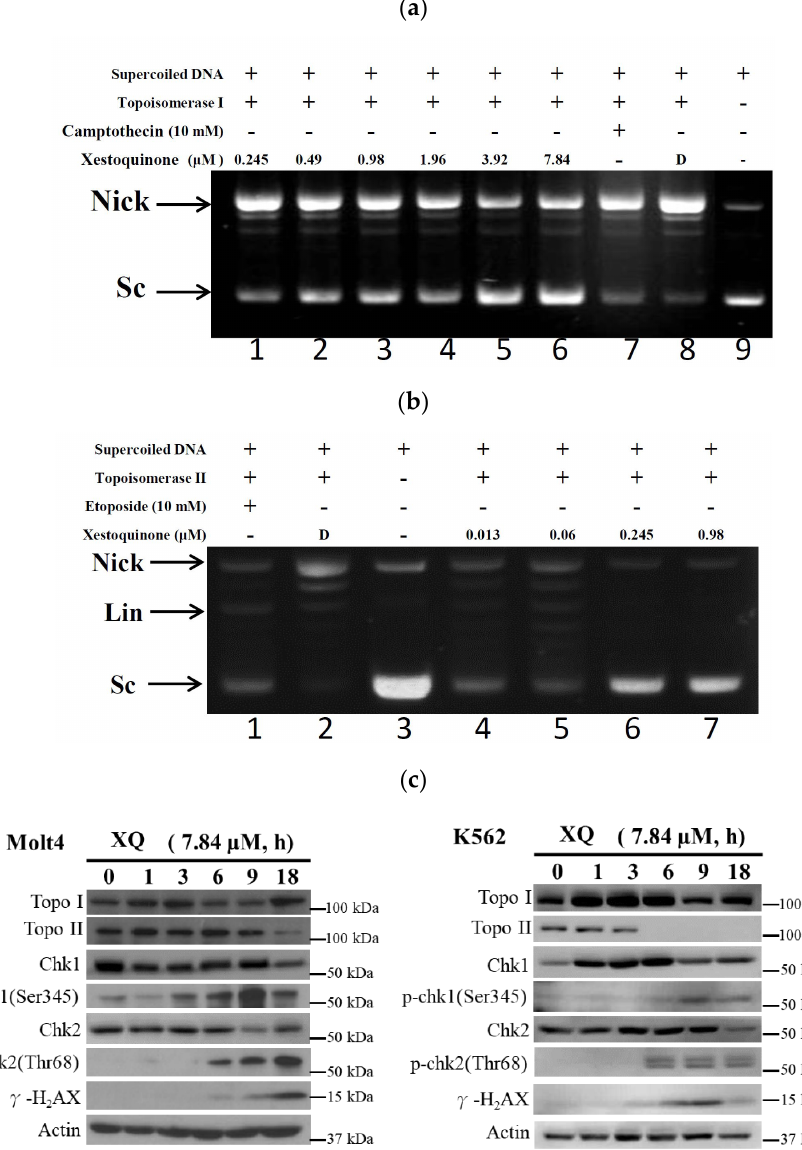
Figure 3. Effect of XQ on Topo I and II activity. ( a ) The effect of XQ on Topo I mediated supercoiled pHOT1 plasmid DNA relaxation with the cell-free system. Lanes 1-6: XQ (0.245, 0.49, 0.98, 1.96, 3.92, and 7.84 µM); Lane 7: Positive control, camptothecin (10 mM); Lane 8: Plasmid DNA + Topo I + solvent control (induction of DNA relaxation); Lane 9: Negative control plasmid DNA (supercoiled DNA). Nick, nicked DNA; Sc, supercoiled DNA. ( b ) The effect of XQ on Topo II mediated supe- coiled pHOT1 plasmid DNA relaxation with the cell-free system. Lane 1: Positive control, etoposide (10 mM), as Topo II poison (induction of linear DNA); Lane 2: Plasmid DNA + topo IIα + solvent control (induction of DNA relaxation); Lane 3: Negative control plasmid DNA (supercoiled DNA). Lanes 4-7: XQ (0.013, 0.06, 0.245, and 0.98 µM). Nick, nicked DNA; Sc, supercoiled DNA; Lin, linear DNA. ( c ) Effect of XQ on the expression of topo IIα and DNA damage -related proteins of Molt-4 cells and K562 cells. Molt-4 and K562 cells were treated with XQ (7.84 µM) for the indicated time intervals. The protein expression was analyzed with Western blotting. Actin was used as the loading control. 2.4. Xestoquinone Inhibited Histone Deacetylases (HDACs) in Human Leukemia Molt-4 Cells Recent reports indicated that HDACs modify topoisomerases’ activity [35]. HDACs’ expressions were determined by Western blotting assay using the Molt-4 cells’ model. A significant decrease in the expressions of HDACs including HDAC 3, HDAC 4, HDAC 6,